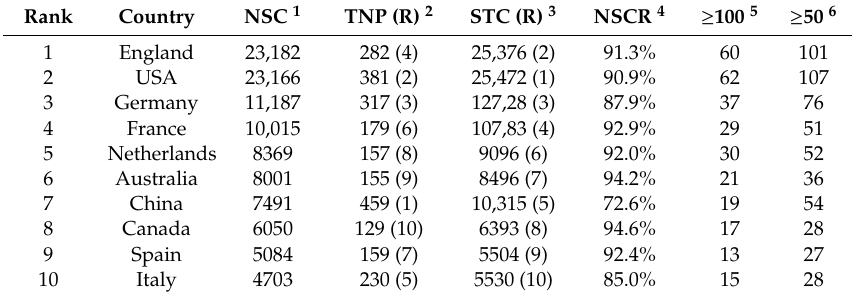
Table 1. The top 10 countries for MPs research ranked by NSC; values for other criteria are given as well.